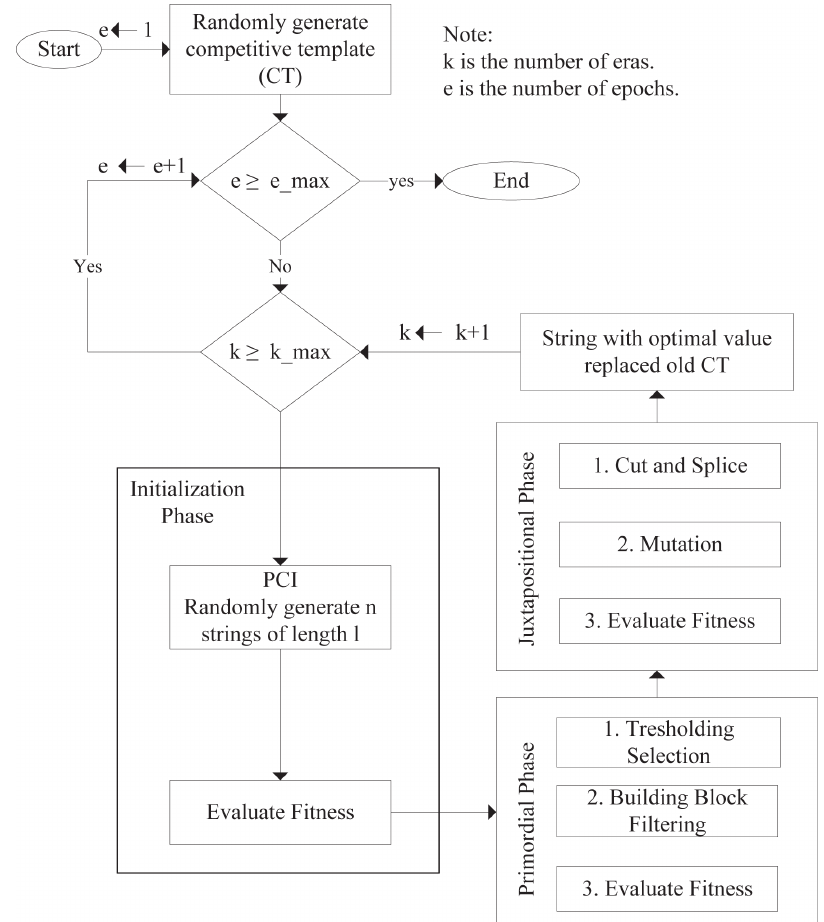
Fig. 1. Illustration of